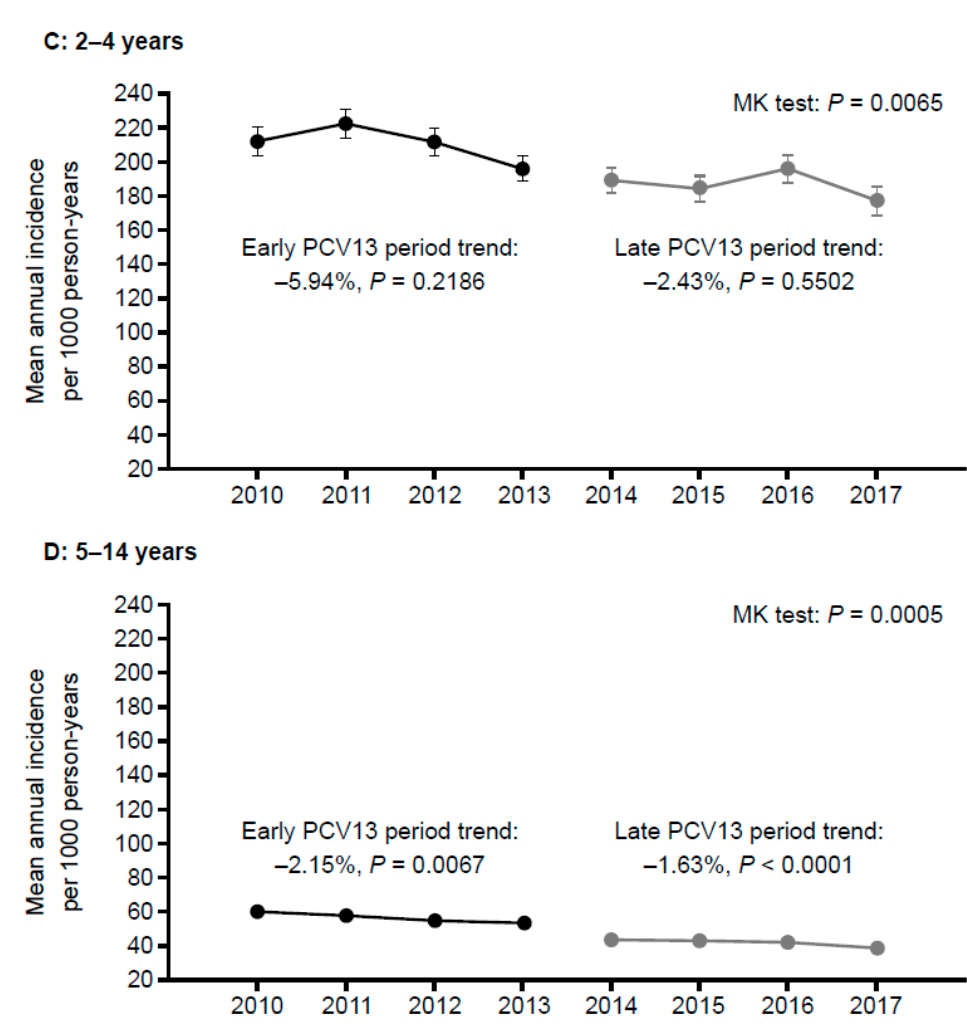
Figure 1. Interrupted time series of mean annual AOM incidence in the pediatric population: ( A ) 0–14 years; ( B ) <2 years; ( C ) 2–4 years; and ( D ) 5–14 years of age; AOM, acute otitis media; MK, Mann–Kendall; PCV13, 13-valent pneumococcal conjugate vaccine.